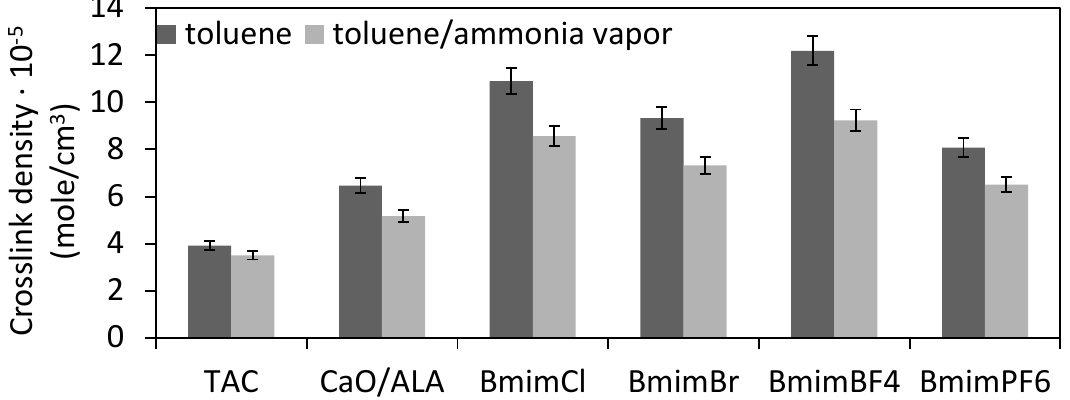
Figure 6. Crosslink densities of silica-filled EPM vulcanizates determined using equilibrium swelling in toluene and toluene with ammonia vapour.